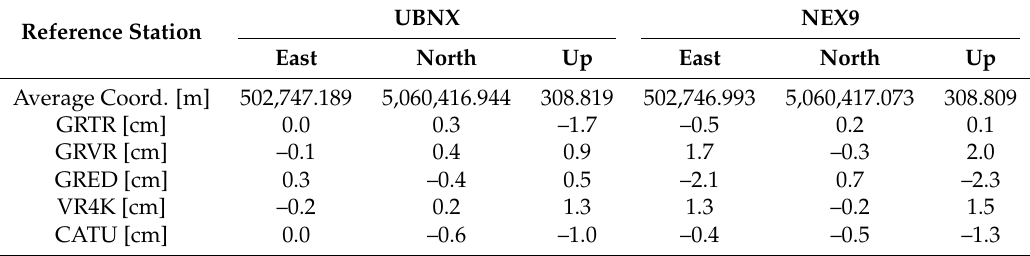
Table 1. Average coordinates obtained for the 1.5-h survey with different base stations on the first row (unit is meter, UTM (Universal Transverse Mercator) coordinate system), and differences between each solution and the average one (unit is centimeter). UBNX NEX9 Reference Station East North Up East North Up Average Coord. [m]